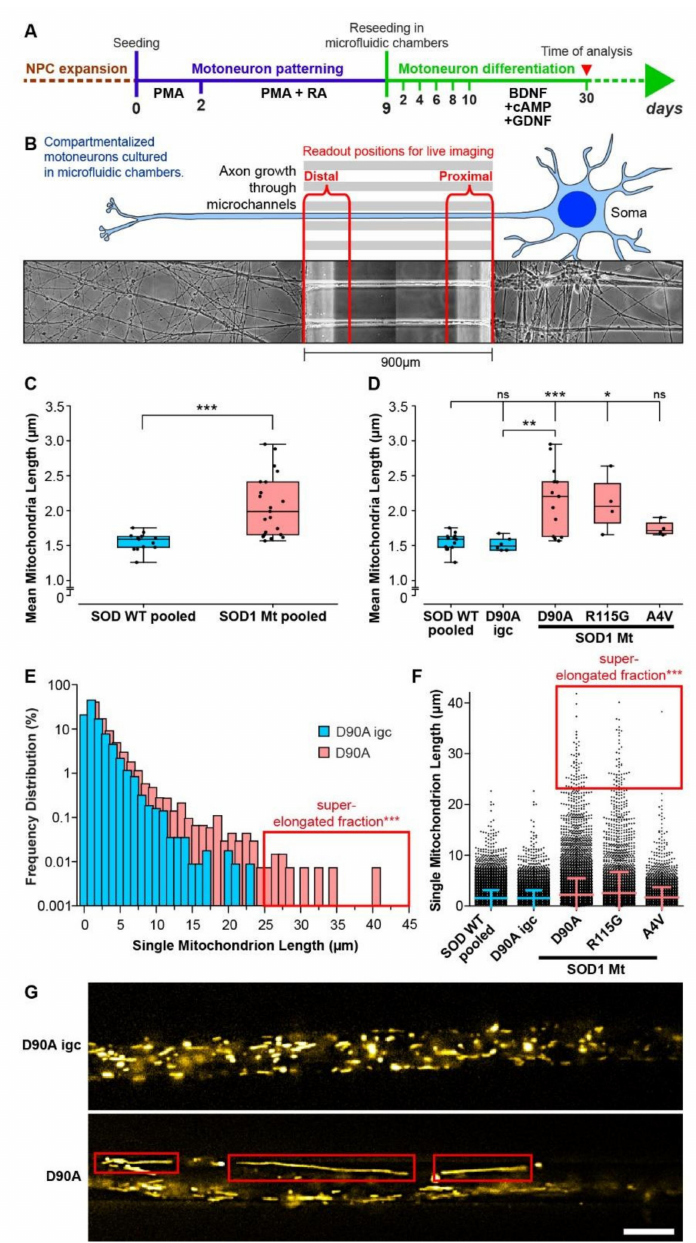
Figure 4. Increased elongation of mitochondria in mutant SOD1 spinal MNs. ( A ) Scheme of the differentiation pipeline to obtain iPSC-derived spinal motoneurons from patients, starting from cryopreservable neuronal precursor cells (NPCs). PMA: phorbol-12-myristate-13-acetate, RA: retinoic acid, BDNF: brain-derived neurotrophic factor, cAMP: cyclic adenosine monophosphate, GDNF: glia cell line-derived neurotrophic factor. ( B ) Cartoon of the live setup of MNs in microfluidic chambers (MFCs). The central microgroove of channels formed a physical barrier between the distal (left) and proximal (right) site where the somata were seeded. Only axons, not dendrites, could penetrate the microchannels. ( C , D ) Box plots of mean mitochondrial length values per experiment (black dots) for each respective line with 25–75% interquartile range (box), median (horizontal line) and non-outlier range (1.5-fold interquartile range added above and below to box, whiskers). SOD Wt pooled ( C , D , F ): data from all SOD Wt lines including D90A igc ( n = 6) were pooled ( n = 13) as listed in Table 1. SOD Mt pooled (C): data from D90A ( n = 13), R115G ( n = 4), and A4V ( n = 4) (Table 1) were pooled ( n =